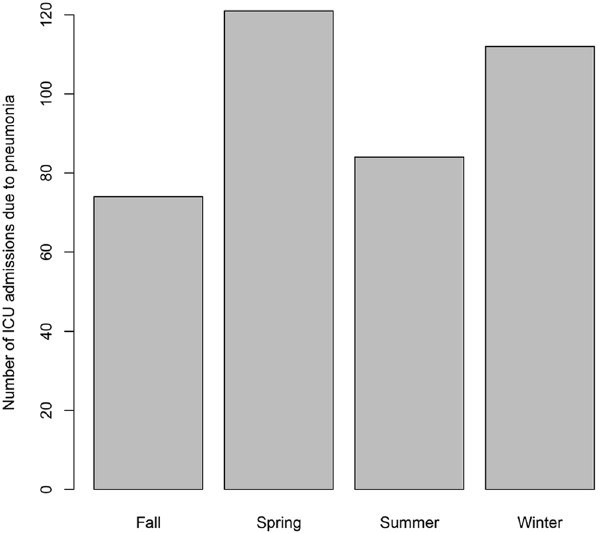
Figure 1. Seasonal variation of ICU admissions due to pneumonia (ICUp). There were more number of ICUp in winter and spring than that in fall and summer ( χ 2 = 15.3, df = 3, p =